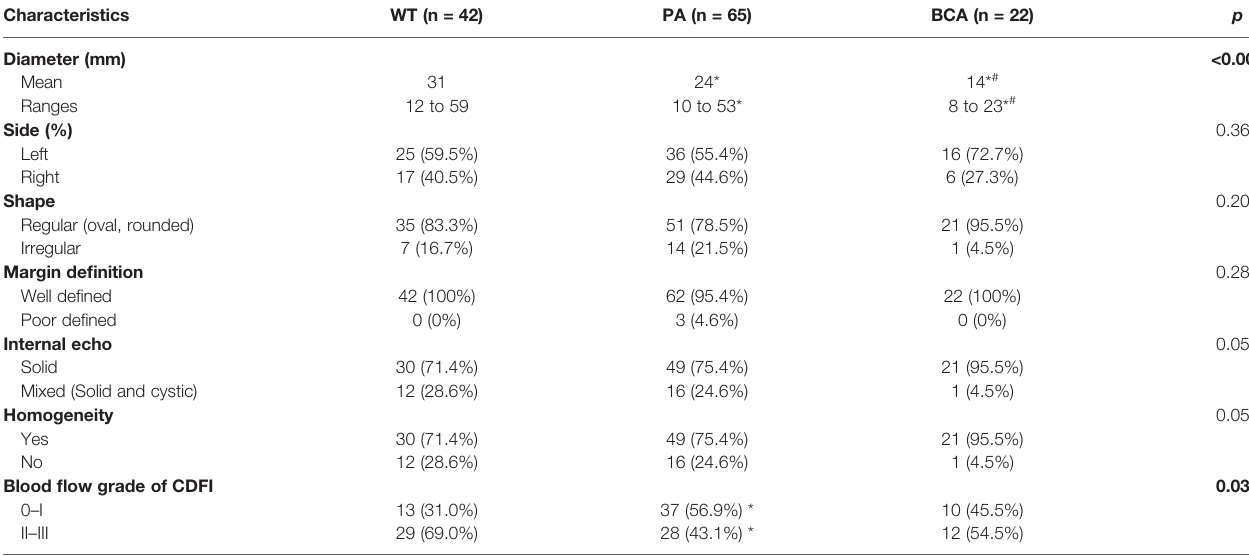
TABLE 2 | Clinical and conventional US characteristics of nodules (n = 129) in the parotid gland. Characteristics